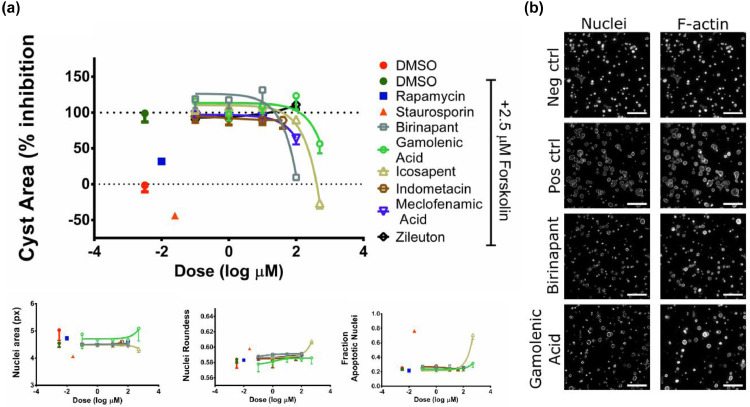
3D-cysts assay of candidate compounds. (a) Top: Quantification of cyst size of the tested compounds normalized to forskolin induced swelling. Reference compounds rapamycin (0.01 µM) and staurosporin (0.25 µM) reduce cyst size, as well as brinapant, Gamolenic Acid, icosapent and Meclofenamic Acid at highest tested concentration of 100 µM, 500 µM, 500 µM and 100 µM respectively (N = 4 wells). Bottom: Assessment of staurosporin-like induction of toxicity. Graphs representing average nuclei area, nuclei roundness and the fraction of nuclei that are apoptotic show changes for reference compound staurosporin and for icosapent. (b)Representative images of positive and negative control and two of the test compounds at highest tested dose; 100 µM for brinapant and 500 µM for Gamolenic Acid. Each scalebar is 400 μM.